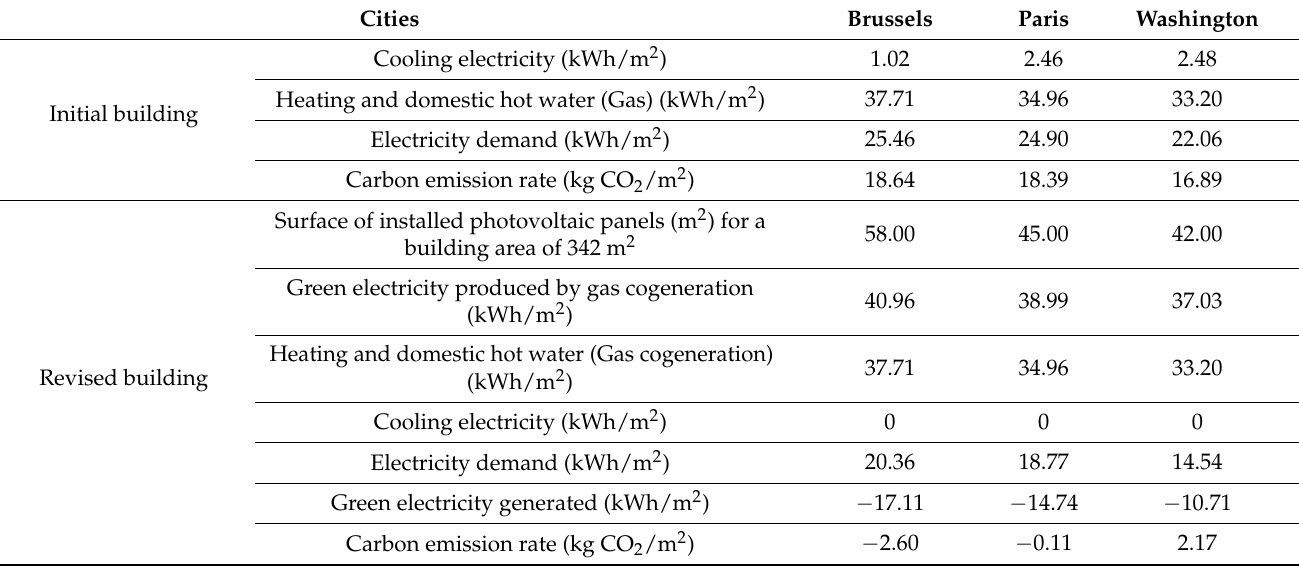
Table 11. Annual operational carbon and electricity demand in the residential buildings located in temperate climates.